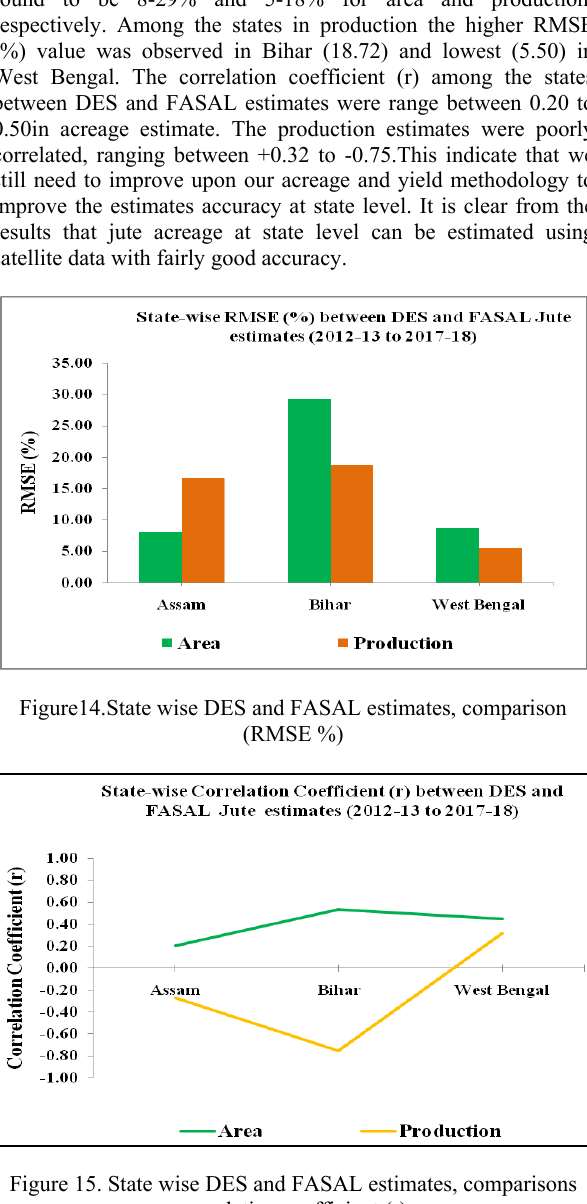
Figure 15. State wise DES and FASAL estimates, comparisons correlation coefficient